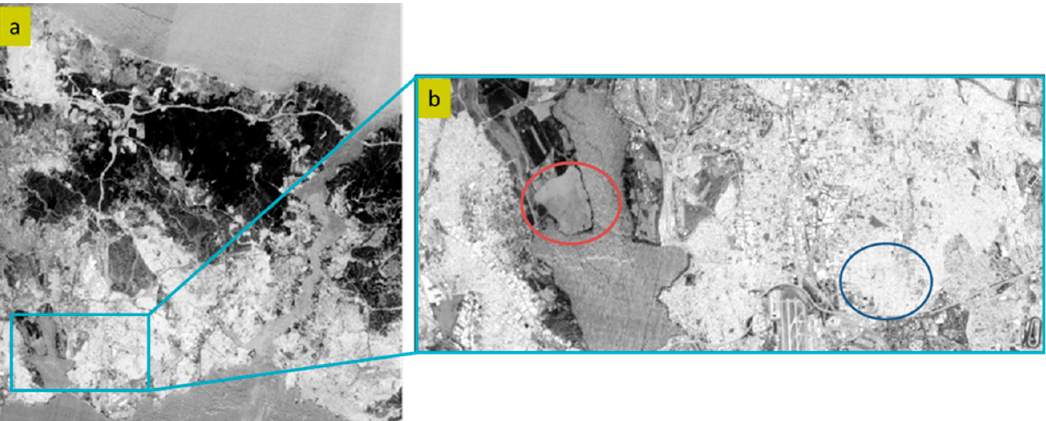
Figure 4. Images of ( a ) the Normalized Difference Tillage Index (NDTI) and ( b ) a subset of NDTI exemplify the contrast between bare land and built-up regions.